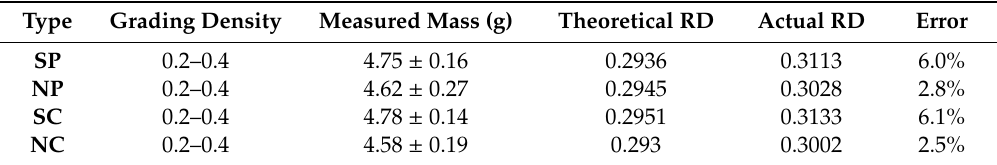
Table 3. Relative densities (RD) of fabricated samples.